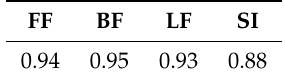
Table 3. Threshold values computed by means of the ROC